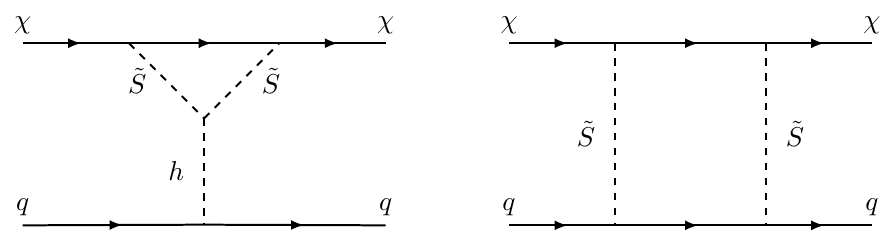
Figure 11 . Representative loop diagrams contributing to the scattering cross-section on nucleons in the case of a pseudoscalar